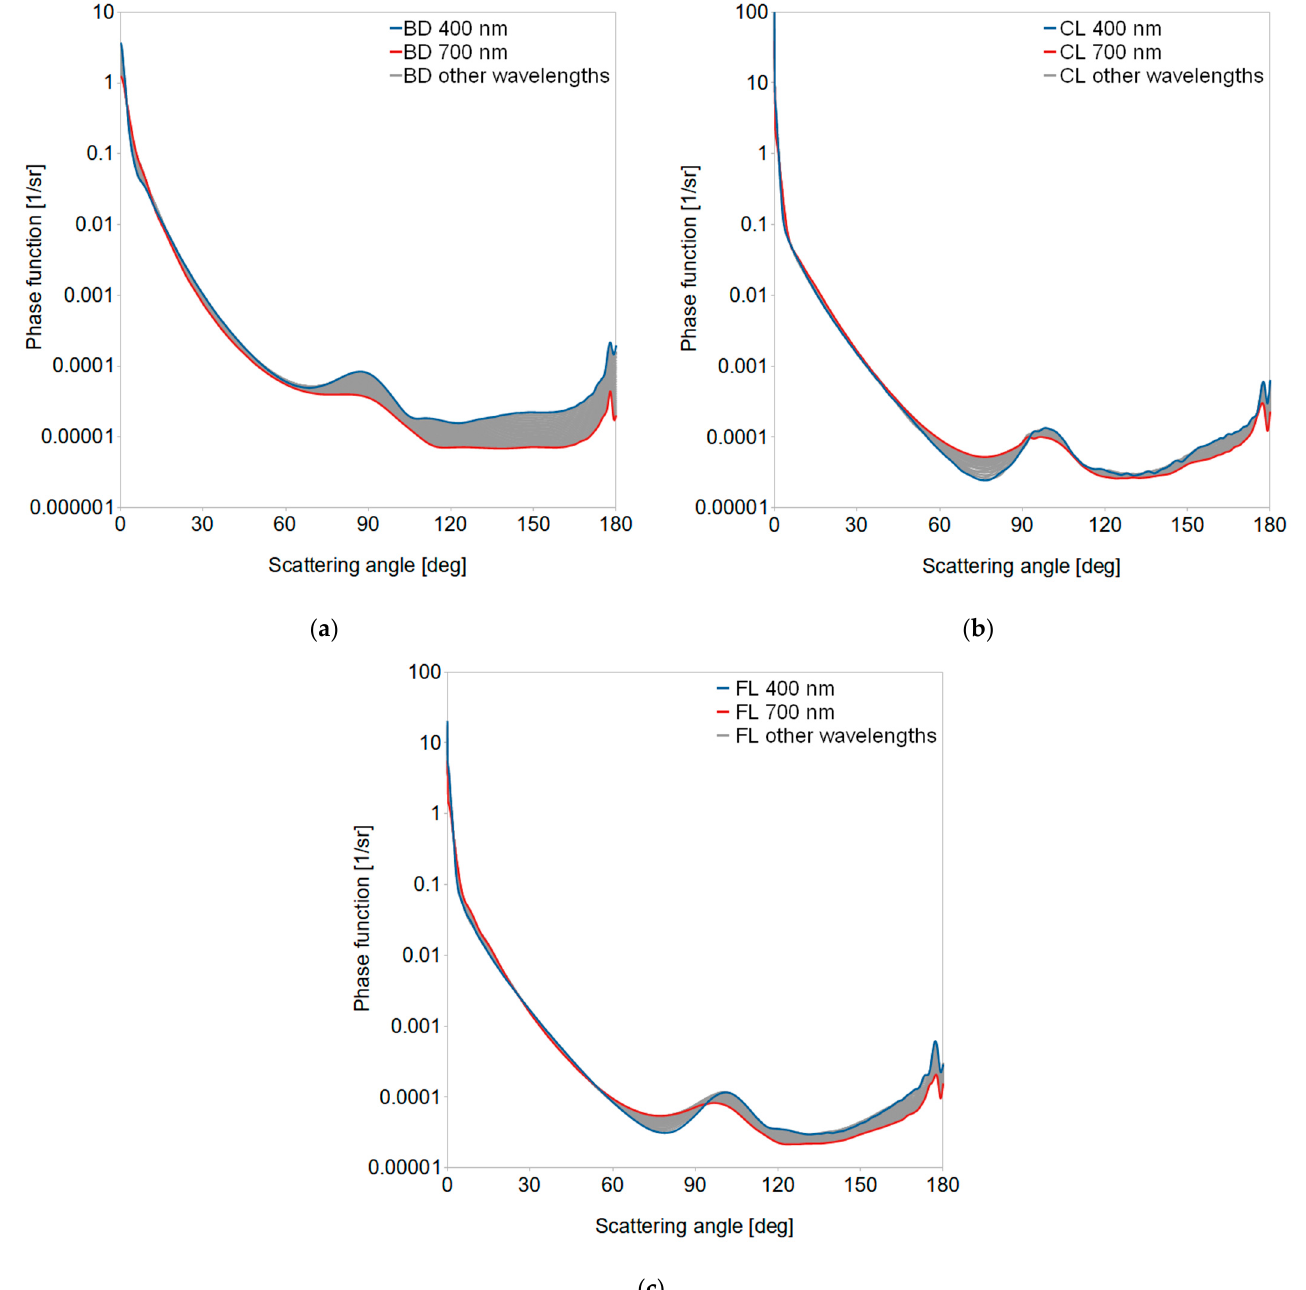
Figure 6. Scattering phase functions from Mie calculations for three kinds of dispersed oils: ( a ) biodiesel BD, ( b ) lubricant oil CL and ( c ) crude oil FL, within the borders of visible spectral range (400 and 700 nm).